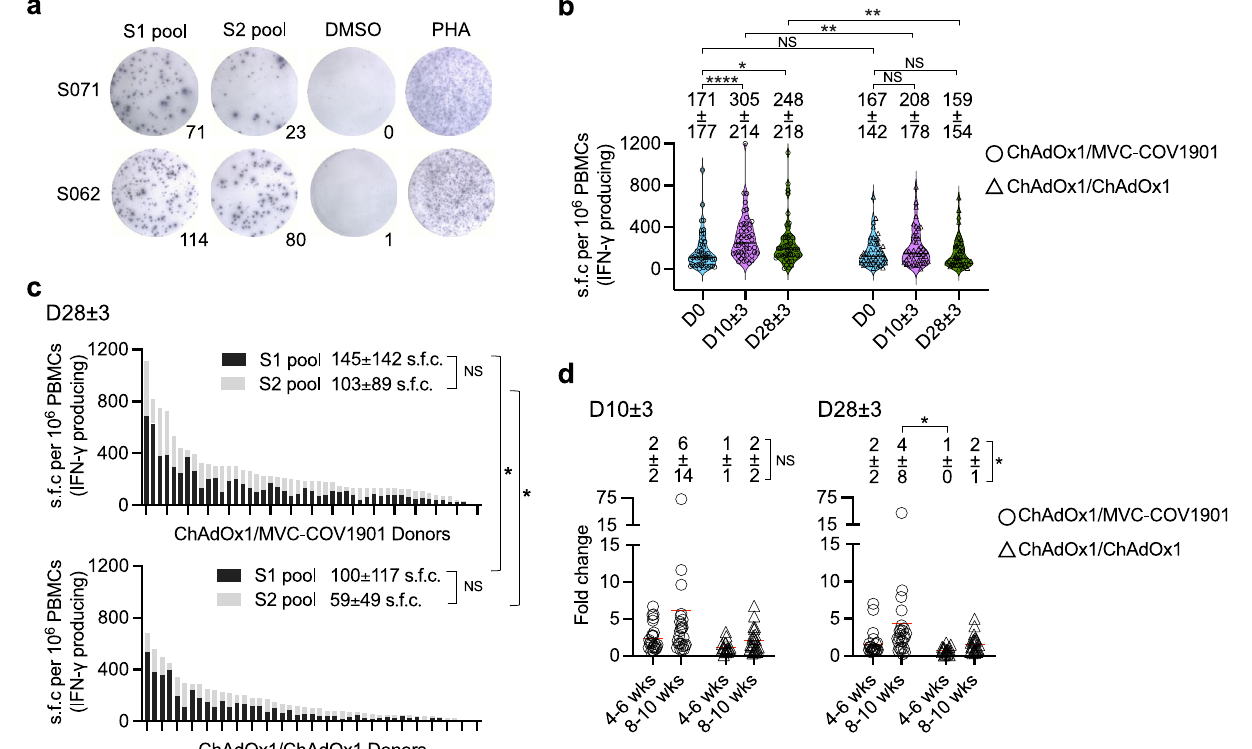
recipients according to spike peptide pools (mean±standard deviation). The sig- ni fi cancewasdeterminedusing one-wayANOVAwithposthocDunn ’ stest.S1pool comparison, P =0.0345;S2poolcomparison, P =0.0334. d Thefoldchangeoftotal spike-speci fi c T-cell responses on day 10±3 (left panel) and 28±3 (right panel) relative to the response prior to the booster dose in short (4 – 6 weeks, n =24 in ChAdOx1/MVC-COV1901 group, n =20 in ChAdOx1/ChAdOx1 group) and long (8 – 10weeks, n =25inChAdOx1/MVC-COV1901group, n =25inChAdOx1/ChAdOx1 group) vaccine dosing intervals (mean±standard deviation). Each point represents a single recipient and red line represents the mean. The signi fi cance was